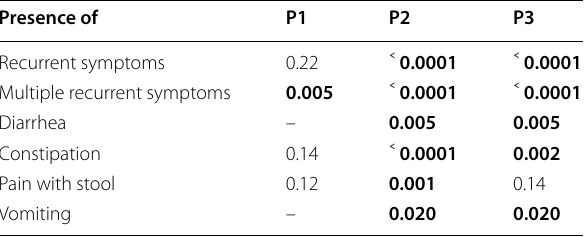
Data are expressed as percentage (number)